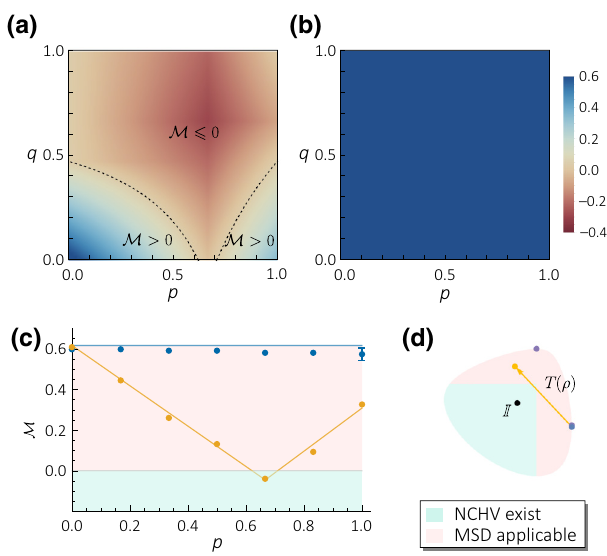
FIG. 5. Topologically protected contextuality. The response of the contextuality witness M to generic noise. (a) The behavior of M in the presence of composite noise T ◦ (cid:14) acting on a non- topological qutrit. The dashed curves mark the classical bound of the NCHV inequality M (cid:2) 0 that distinguishes quantum states that are useful in magic state distillation. (b) The composite noise X S ◦ Z S acts on a parafermionic qutrit, with M exhibiting sta- bility with respect to any amount of noise. (c) The experimental result of the contextual witness M to the amount of hopping (flip) noise. The blue (yellow) line and points correspond to the theoretical predictions and experimental data, respectively, in the parafermionic (nontopological) system. The results here corre- spond to the q = 0 lines in (a) and (b). (d) A visualization of the effect of noise in the qutrit state space. The two coordinates cor- respond to two witnesses of contextuality in Eq. (9). The purple points denote two of the magic states, the point marked I denotes the maximally mixed state, and the orange (blue) points rep- resent the final nontopological (parafermionic) state at p → 1. The pink (cyan) area corresponds to the states that are (not) applicable for magic state distillation. The trajectory of the non- topological qutrit under flip noise T is illustrated by the orange arrow, whereas the hopping noise X S has almost no effect on the parafermionic